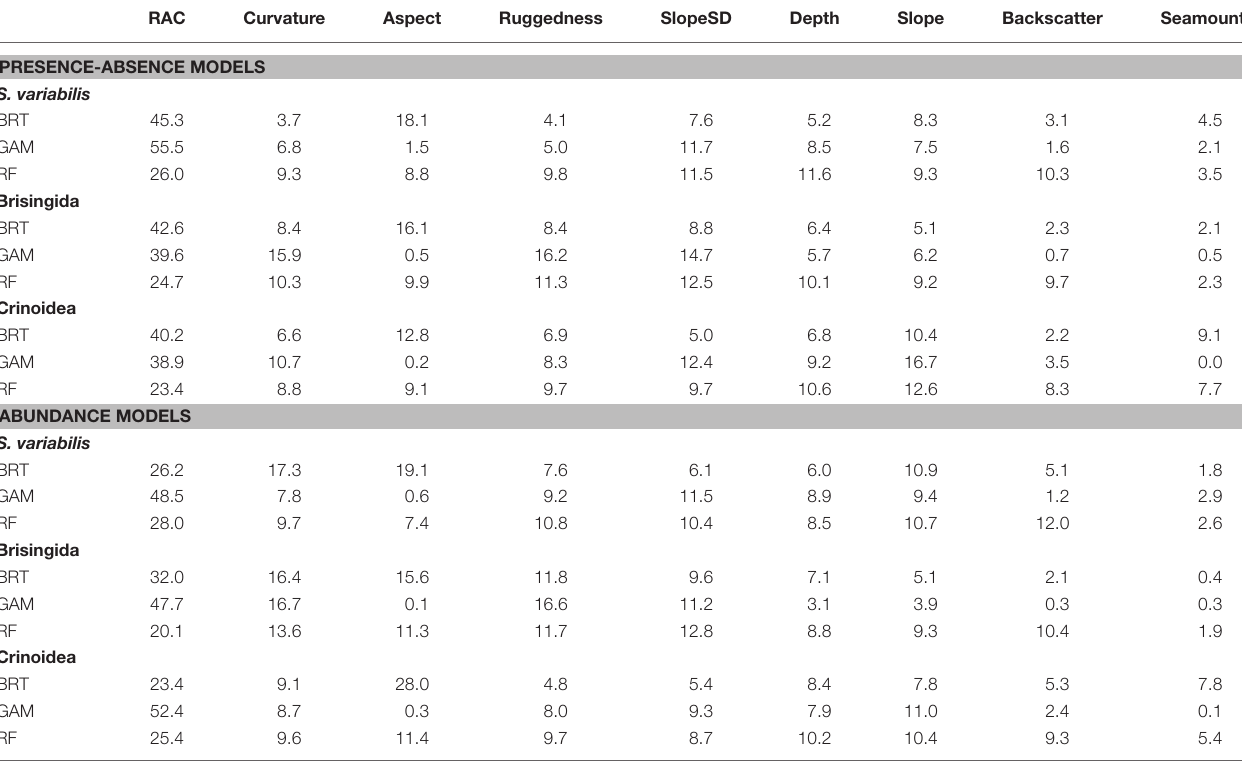
Values are the percentage influence of each variable in each model. See text for an explanation of how these values were calculated. BRT, Boosted Regression Tree; GAM, General Additive Model; RF, Random